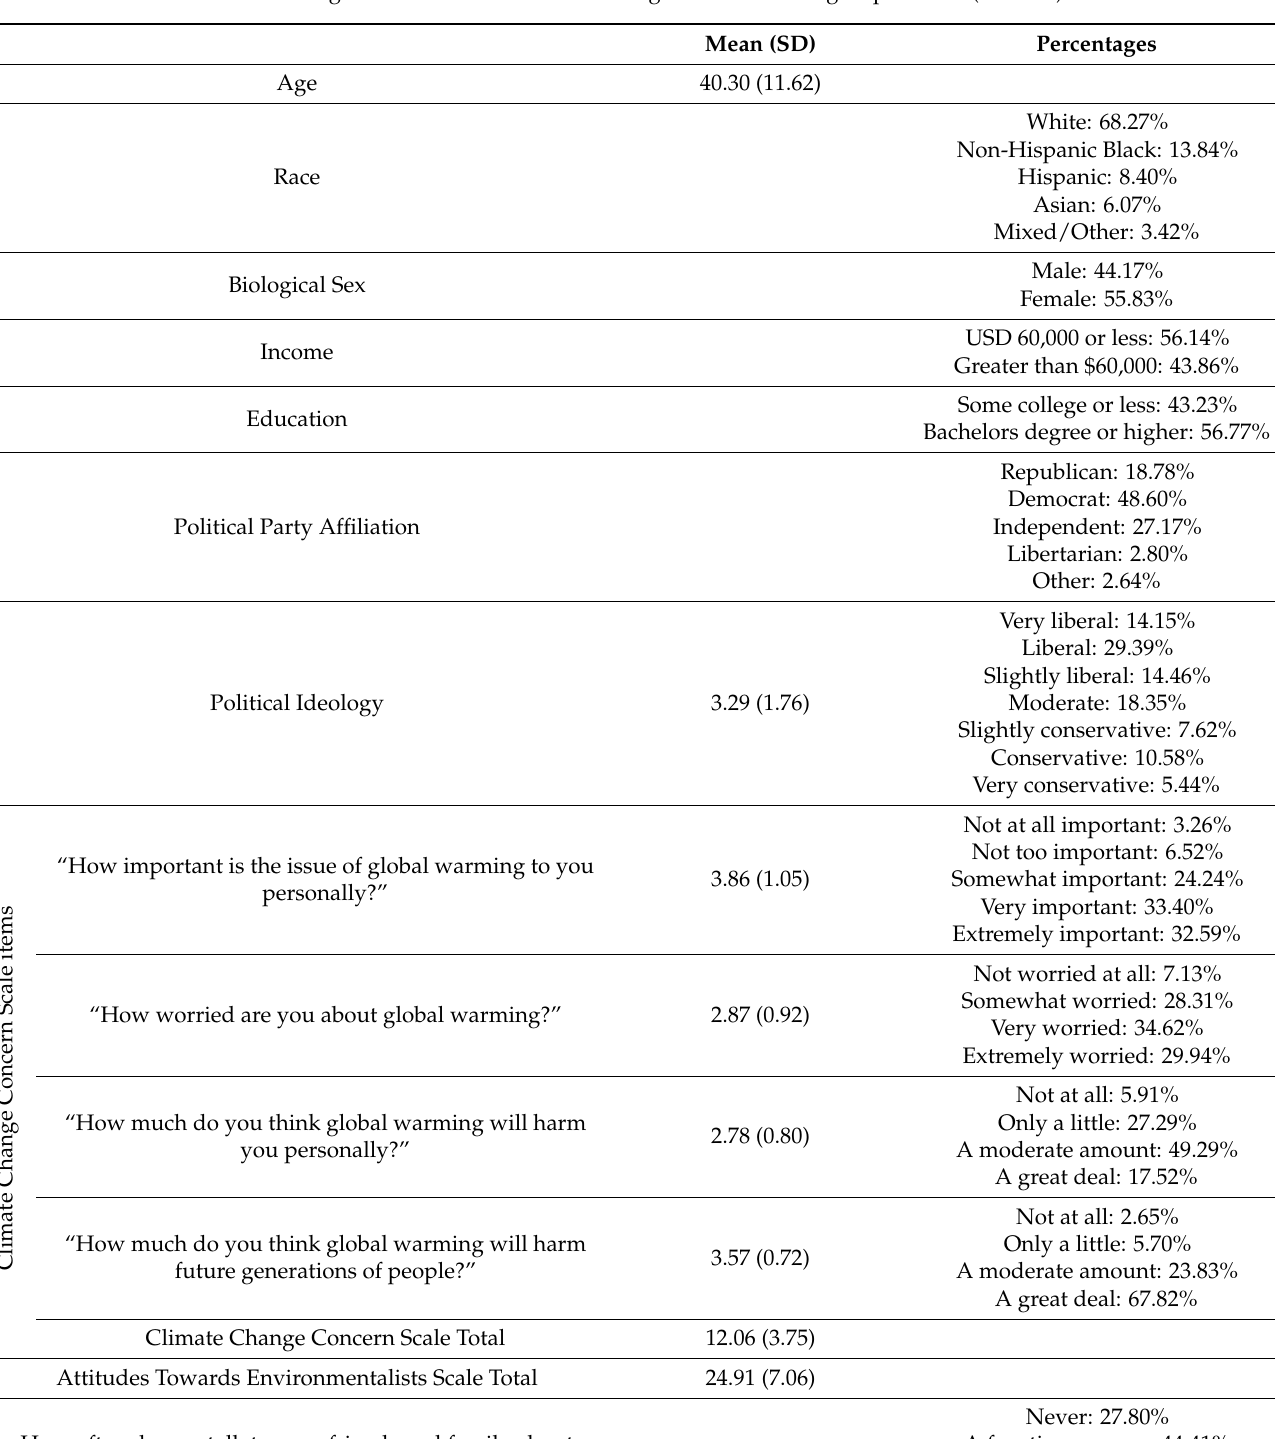
Table 1. Background factors and climate change attitudes among respondents (N =